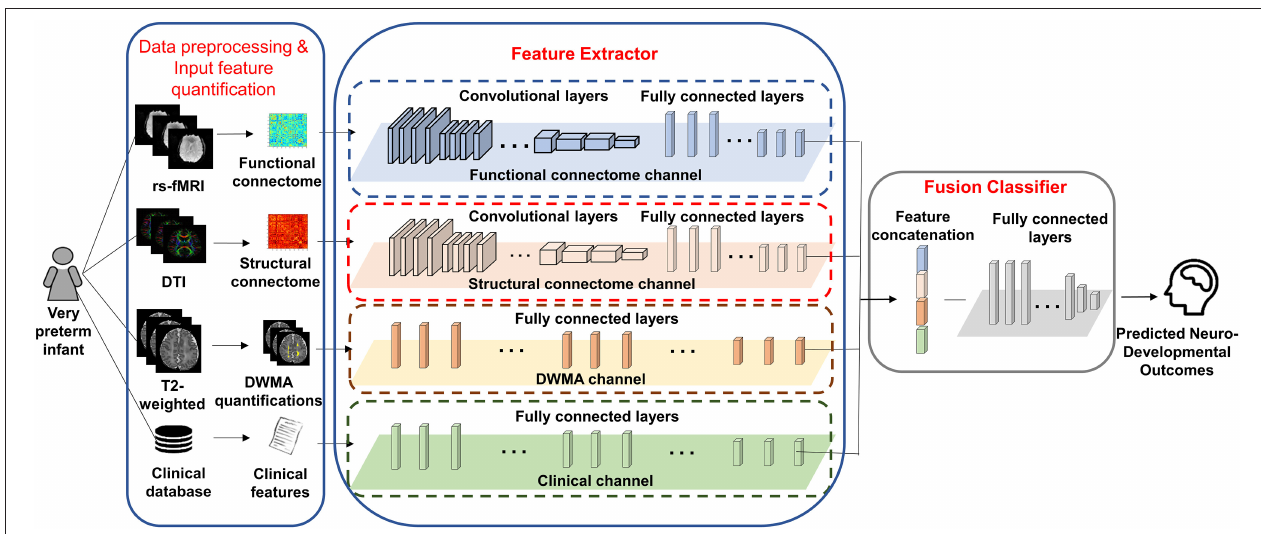
FIGURE 1 | A deep multimodal learning model consists of feature extractor and fusion classifier, for the prediction of neurodevelopmental (cognitive, language, and motor) deficits using MRI and clinical